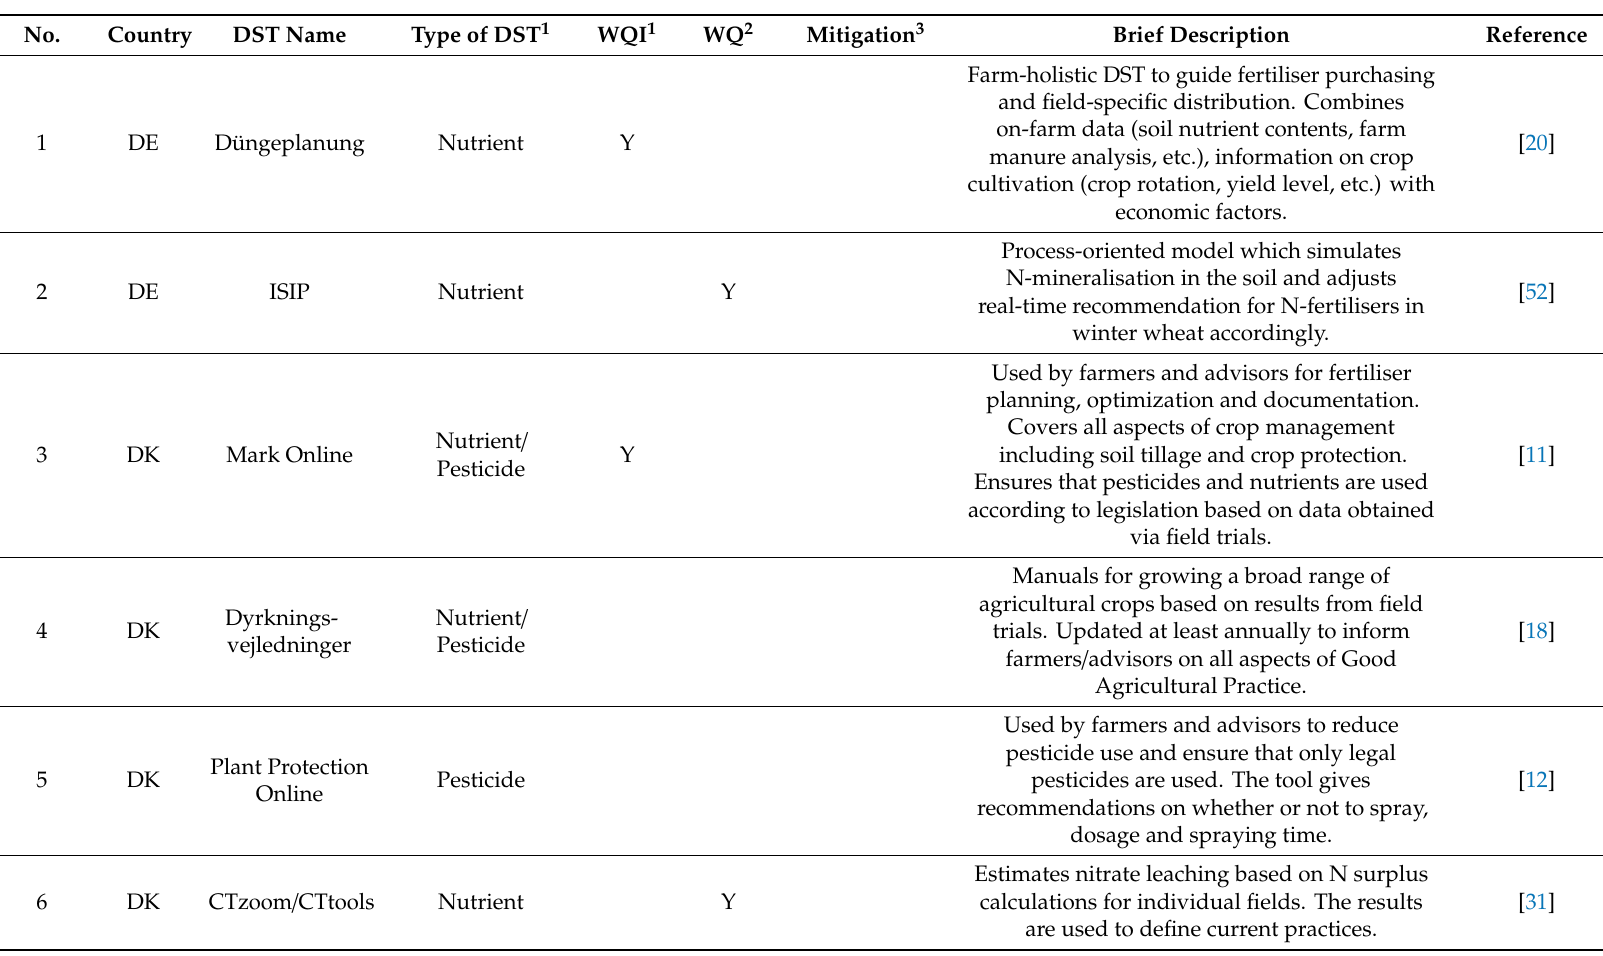
Table A3. Shortlist of DSTs taken forward for further consideration, including summary description and publication reference (where applicable).